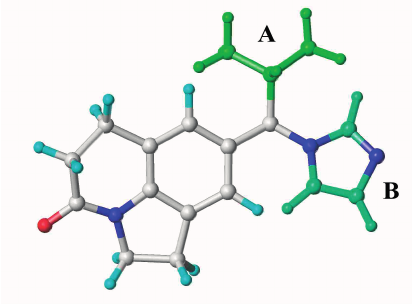
Figure 7. The compound with the highest activity of CYP11B1 inhibition (compound 26 ) combined with A and B